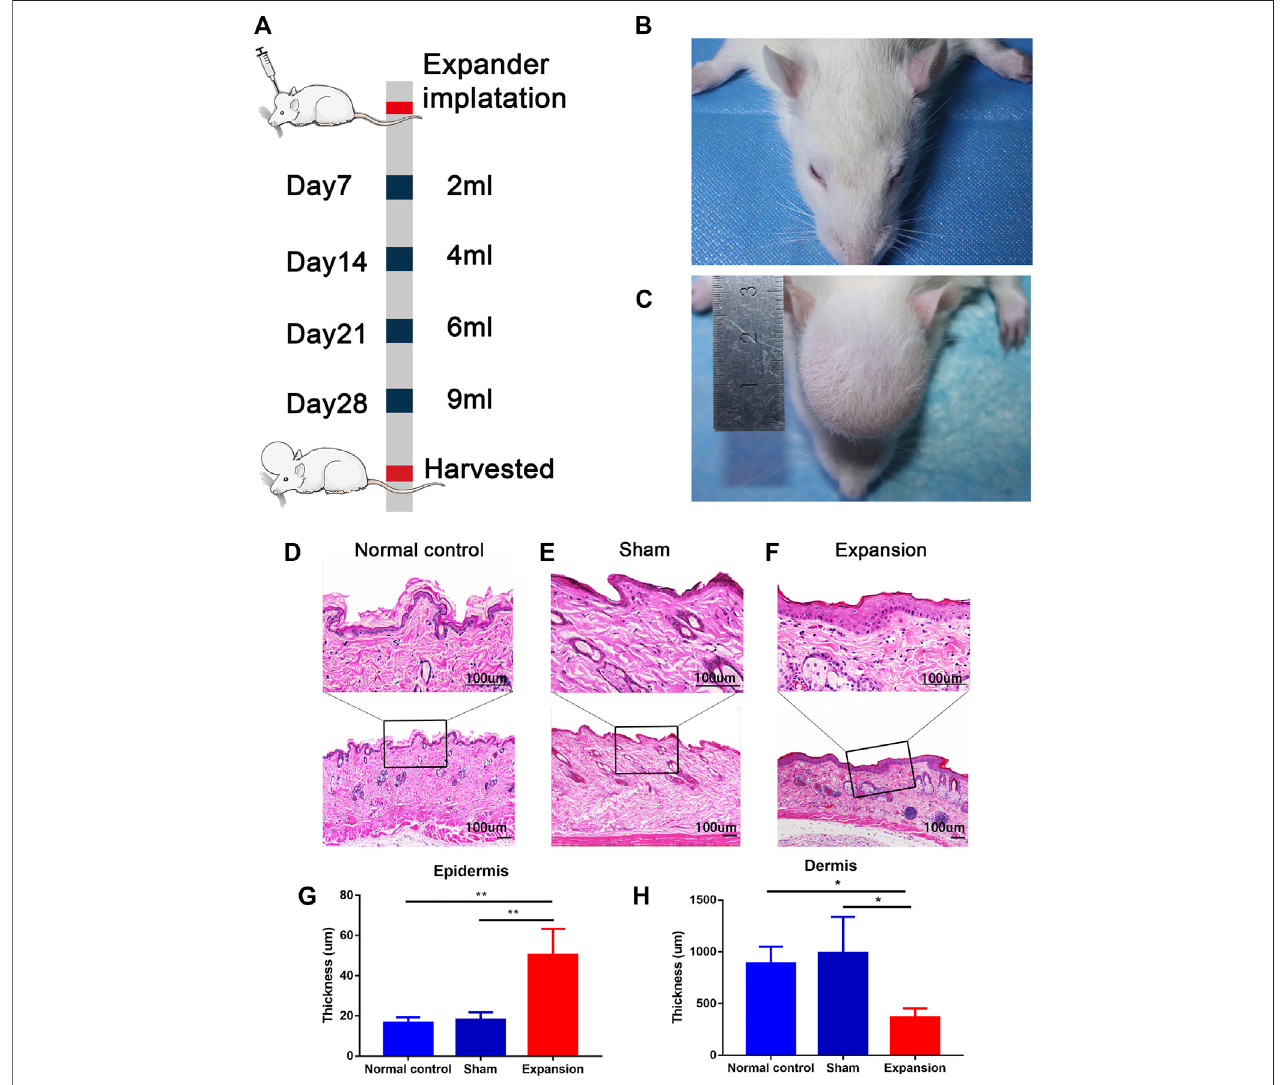
FIGURE 1 | Overview of the study design and histological observation corresponding with morphological change of skin induced by mechanical stretch. (A) Schematic presentation of procedural timeline and expansion volume of scalp skin expansion. (B – C) Representative image of samples located on top of the dome induced by the skin expander and the central region of scalp in the sham operated and normal control group. (D – H) H and E staining showed a thicker epidermis and a thinner dermis thickness in the expanded group ( n (cid:1) 4) than that in the normal control group ( n (cid:1) 3) and the sham operated group ( n (cid:1) 3). scale bar: 100 um * p < 0.05, ** p <